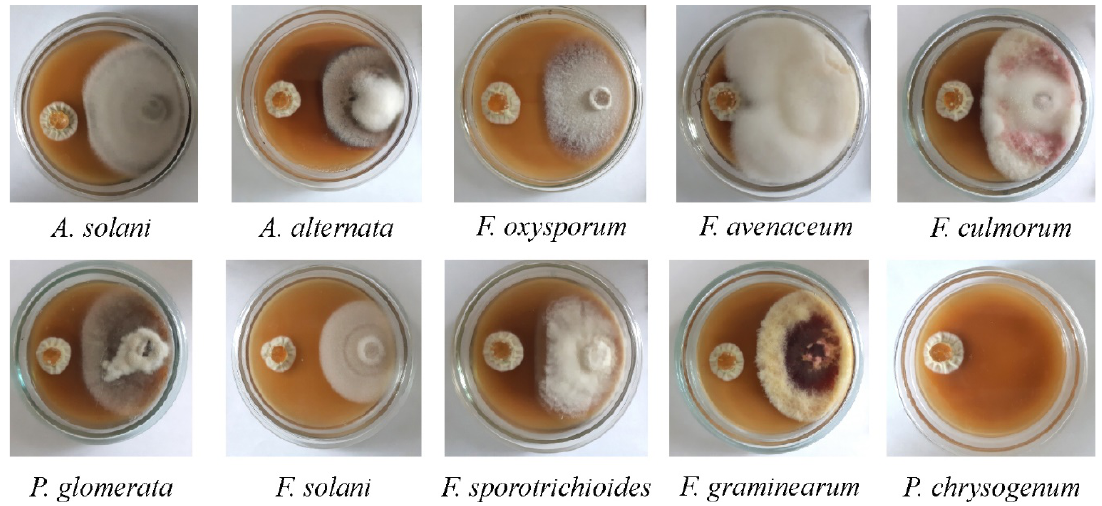
Figure 4. Antagonistic activity of Penicillium chrysogenum F-24-28 towards various plant pathogenic fungi. The pictures were made at the 7th day of co-cultivation.